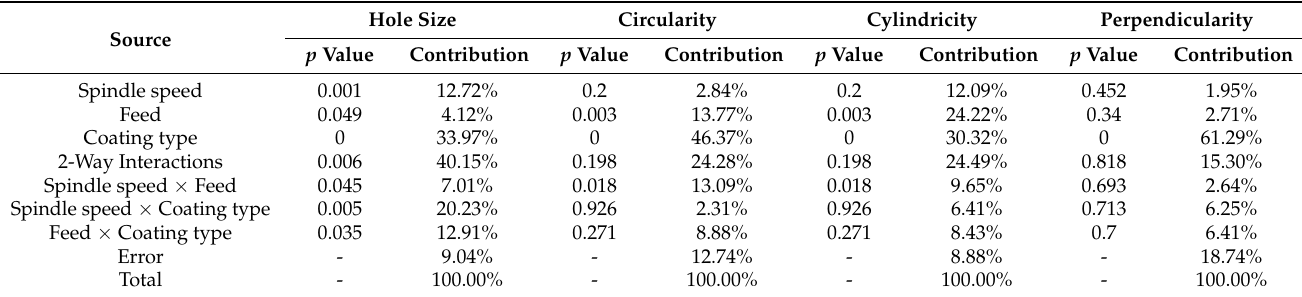
Table 4. Analysis of variance for hole quality.